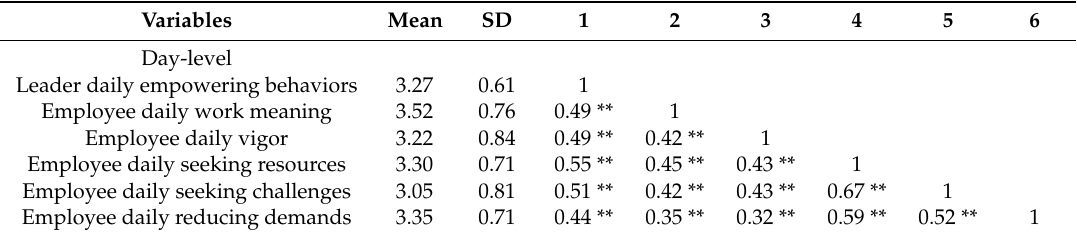
Table 1. Means, standard deviations, and correlations among study